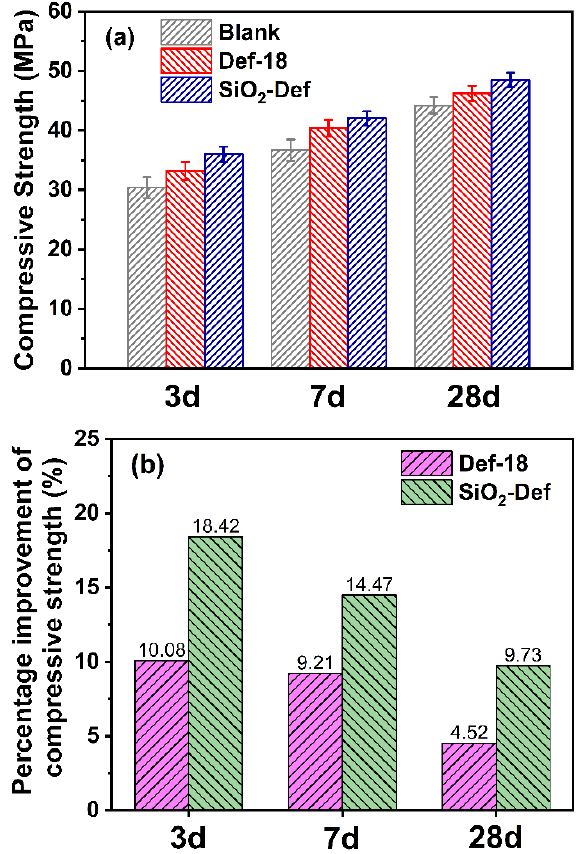
Figure 13. Compressive strengths ( a ) and percentage improvement of compressive strengths ( b ) of the hardened cement mortar specimens of Def-18 and SiO 2